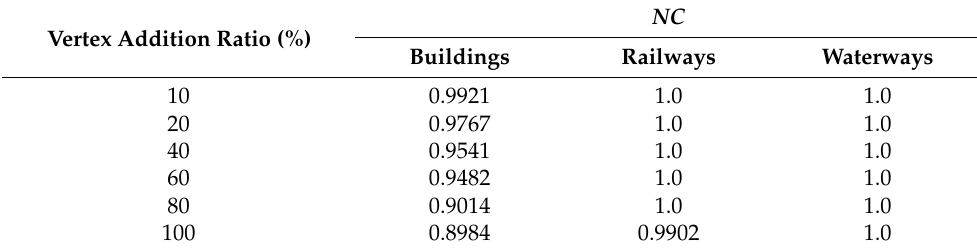
Table 7. The robustness results of vertex addition